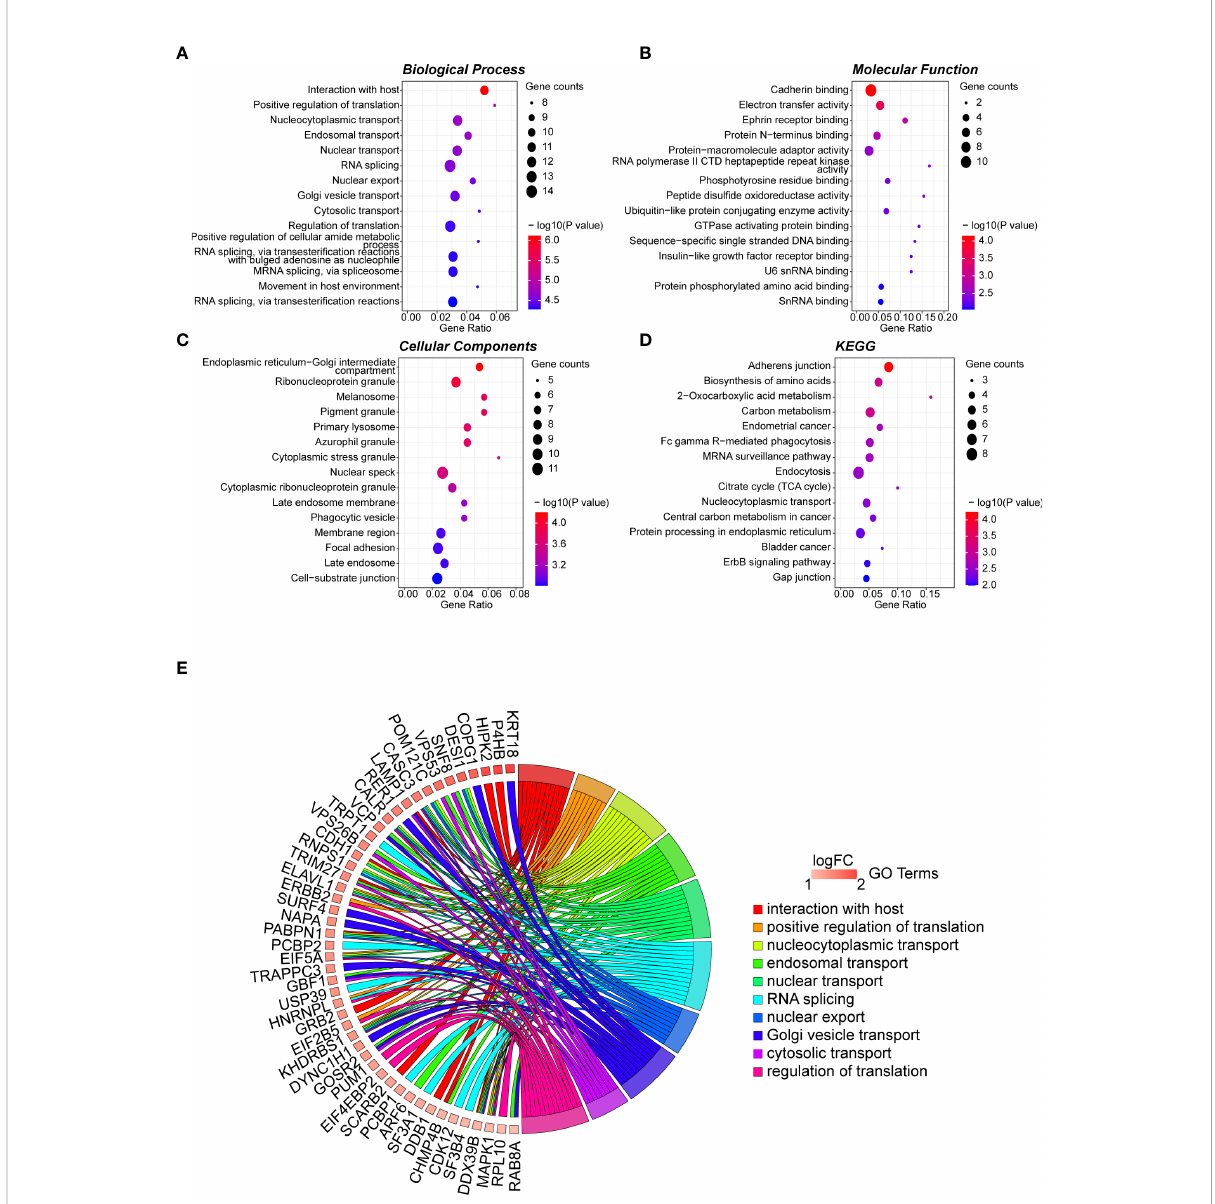
FIGURE 2 GO term analysis for differentially regulated genes. Dotplot for GO enrichment analysis in BP (A) , MF (B) , CC (C) , and KEGG pathway analysis (D) of the 165 hub genes in the green module. The larger the size of a dot, the greater enrichment of genes. The dot colour represents the -log10 (p-value). (E) Network chord plot between the BP-enriched GO terms and their corresponding hub genes. The top 10 terms are presented, and the redder the box below the gene, the greater the log fold change. GO, Gene Ontology; KEGG, Kyoto Encyclopedia of Genes and Genomes; BP, Biological Process; MF, Molecular Function; CC, Cellular